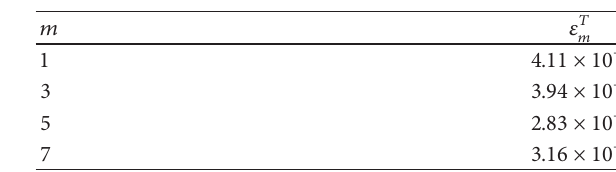
Figure 2: Residual squares of log 10 𝜀 𝑇 𝑚 versus 𝑐 0 . Solid line: 1st-order approximation; long dashed line: 2nd-order approximation; dash- dotted line: 3rd-order approximation. Table 1: The total residual square error 𝜀 𝑇 𝑚 for different approxima- tion order 𝑚 with 𝑐 0 = −0.19